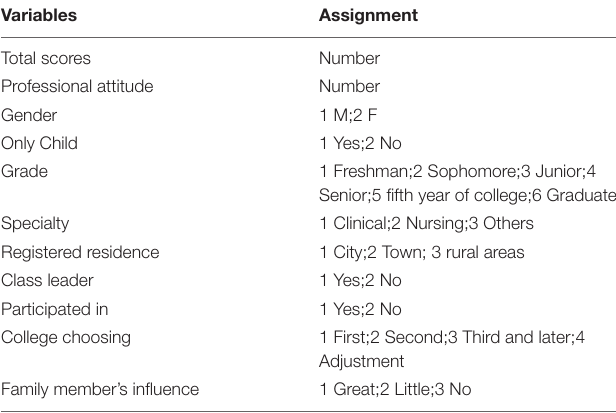
TABLE 9 | Assignment of variables affected medical student’s professional identity.